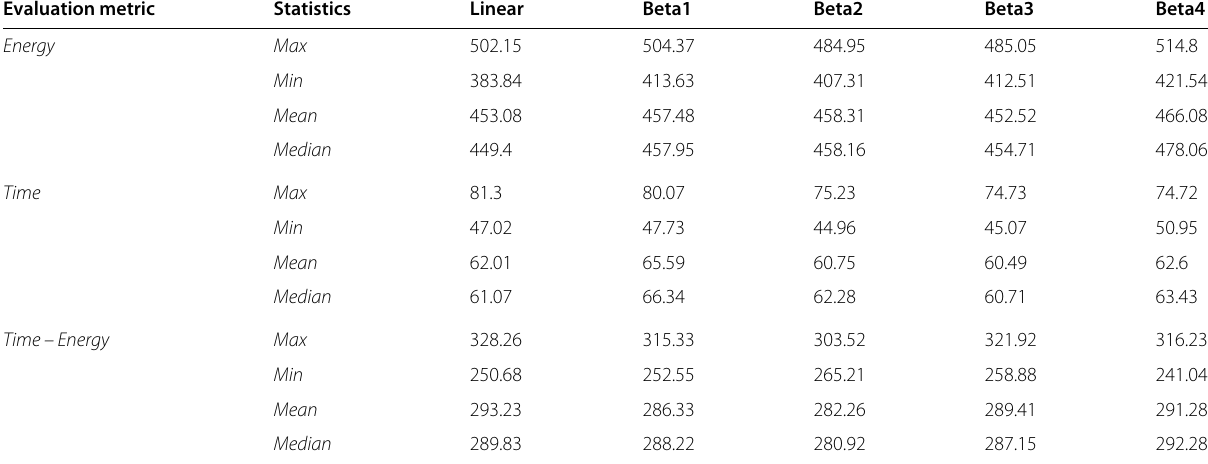
Table 10 Results of 4 non-linear functions on all evaluation metrics Evaluation metric